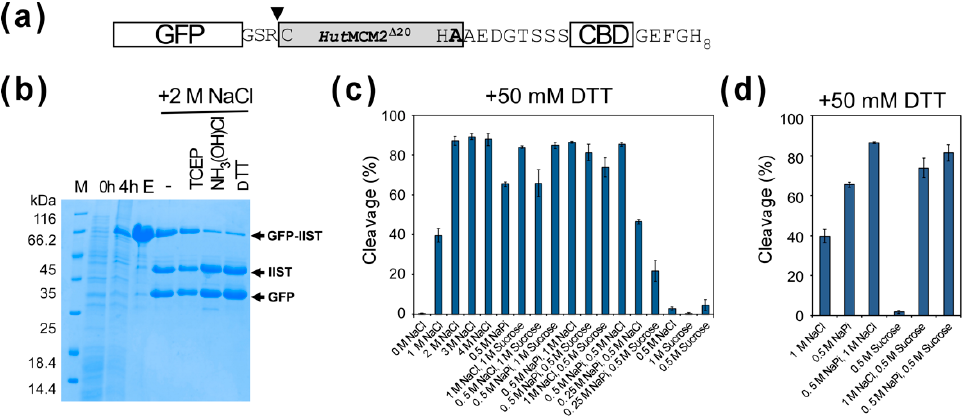
Figure 4. Cleavage tests of GFP-IIST with various conditions. ( a ) A schematic drawing of the construct using GFP with IIST. Only three amino-acid residues between GFP and IIST are shown at the junction. An inverse triangle indicates the cleavage site. ( b ) SDS-PAGE analysis of cleavages of GFP with IIST under 2 M NaCl using different cleavage conditions. M stands for molecular weight markers. Lanes 0 h, 4 h, and E stand for before induction, 4 h after protein expression, and the elution fraction from IMAC, respectively. “-“, TCEP, NH 3 (OH)Cl, and DTT indicate no additive, 0.5 mM tris(2-carboxyethyl)phosphine (TCEP), 100 mM hydroxylamine, and 50 mM DTT, respectively. ( c ) A plot of cleavage efficiencies under various conditions using GFP-IIST. ( d ) A plot shows the additive effects of the co-solvents.